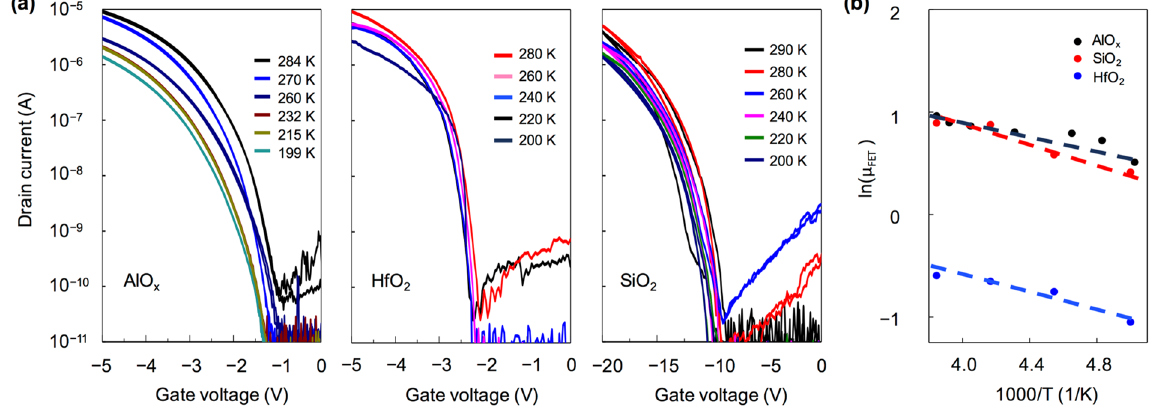
Figure 6. ( a ) Transfer curves of the C 8 -BTBT-based OFETs using AlO x , HfO 2 and SiO 2 under different temperatures. ( b ) Temperature dependence of the field-effect mobility.